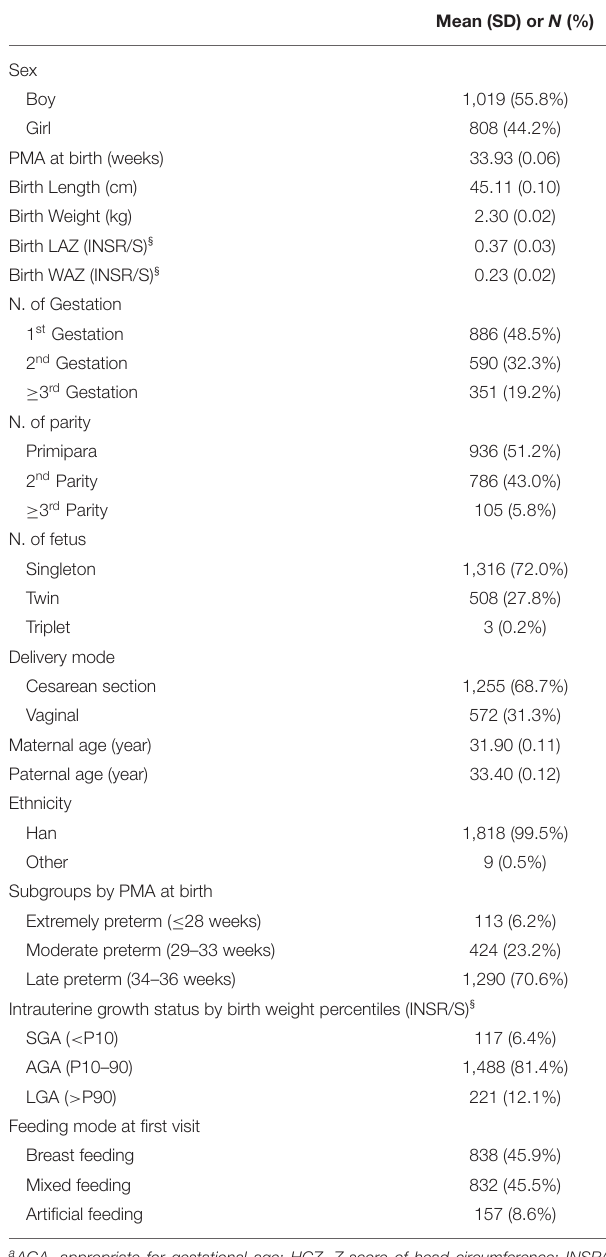
TABLE 1 | Baseline characteristics of 1,827 preterm infants a